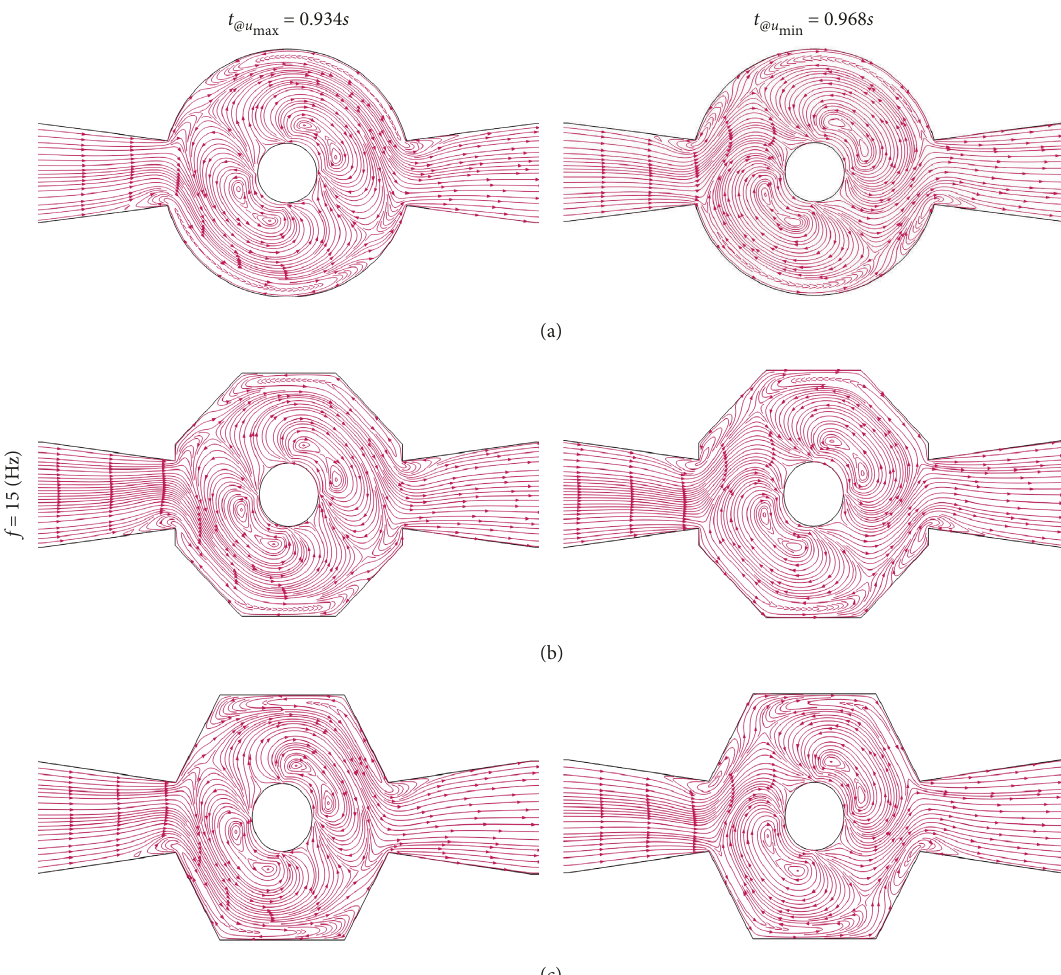
Figure 13: Streamlines in (a) circular, (b) octagonal, and (c) hexagonal mixing chambers for the maximum (left) and minimum (right) velocities in the final cycle at f � 15Hz ( u � 0.1mm · s − 1 , φ � π